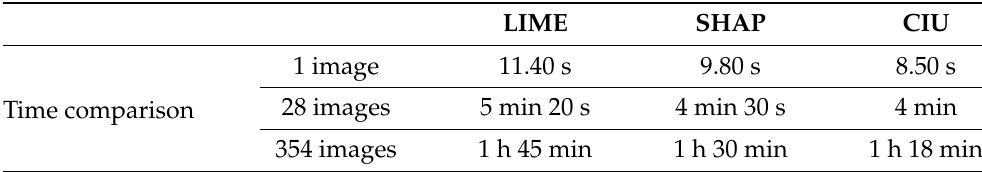
Table 5. LIME, SHAP and CIU time comparison (note: LIME and SHAP were run using Python and CIU was run using R).